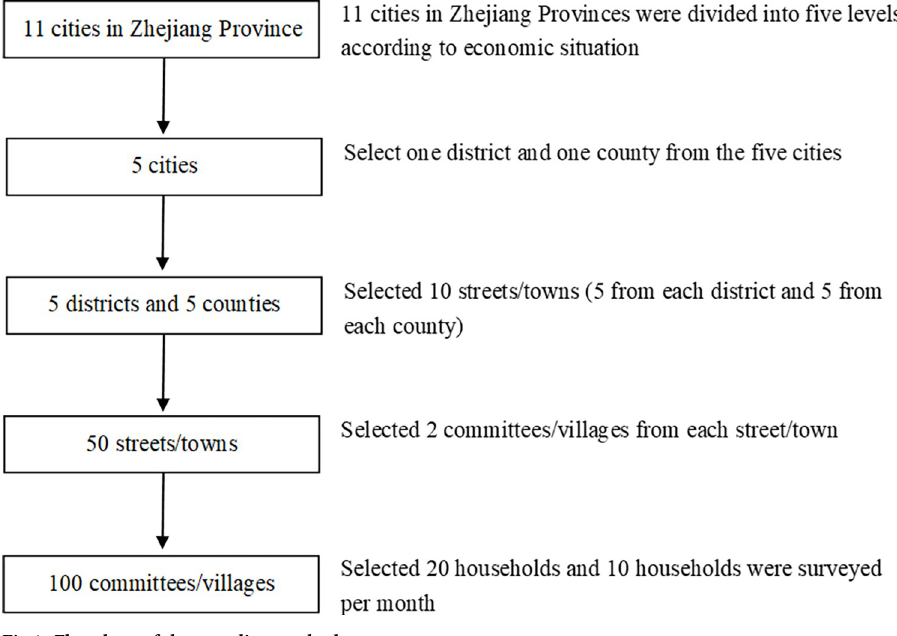
Fig 1. Flowchart of the sampling